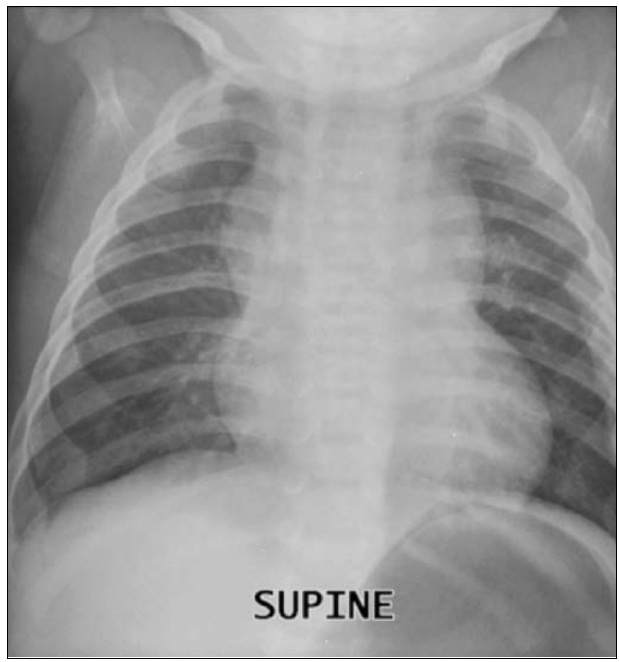
Fig. 3. Frontal chest X-ray demonstrating the classic snowman sign, in keeping with TAPVR type1 and multiple, predominantly left-sided, posterior and lateral rib fractures with callus